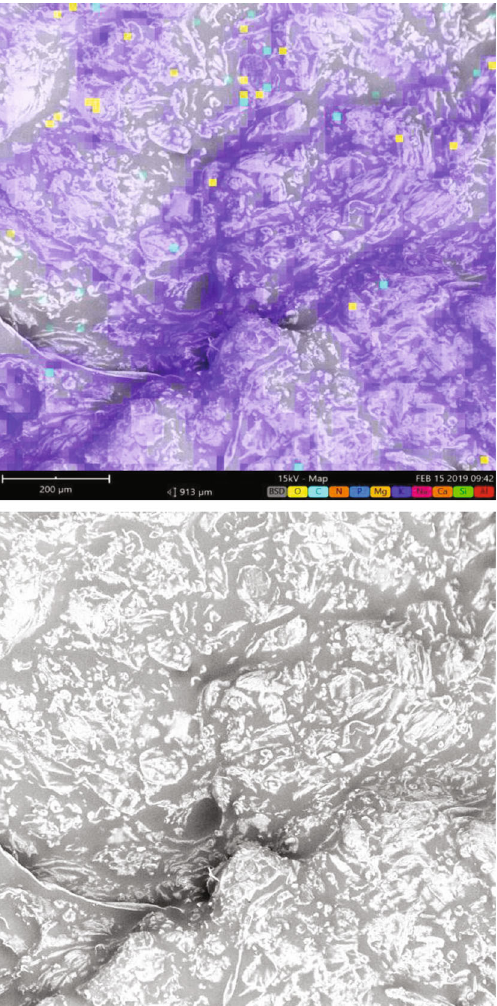
Figure 1: Micrograph of Colombian coastal Carimañolas obtained by vacuum frying.